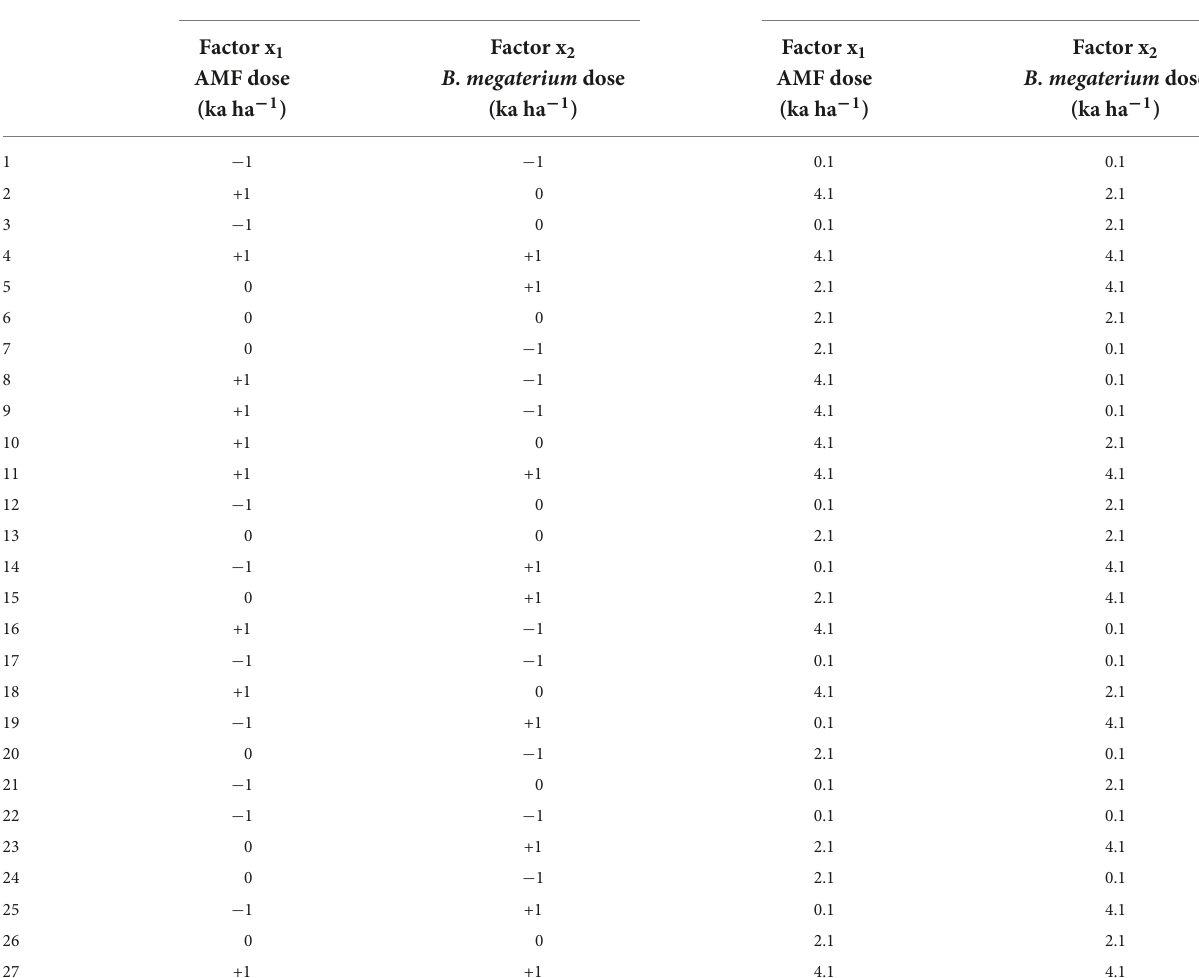
TABLE 1 RSM–CCD matrix for response surface analysis on the maize experiment. Run Coded